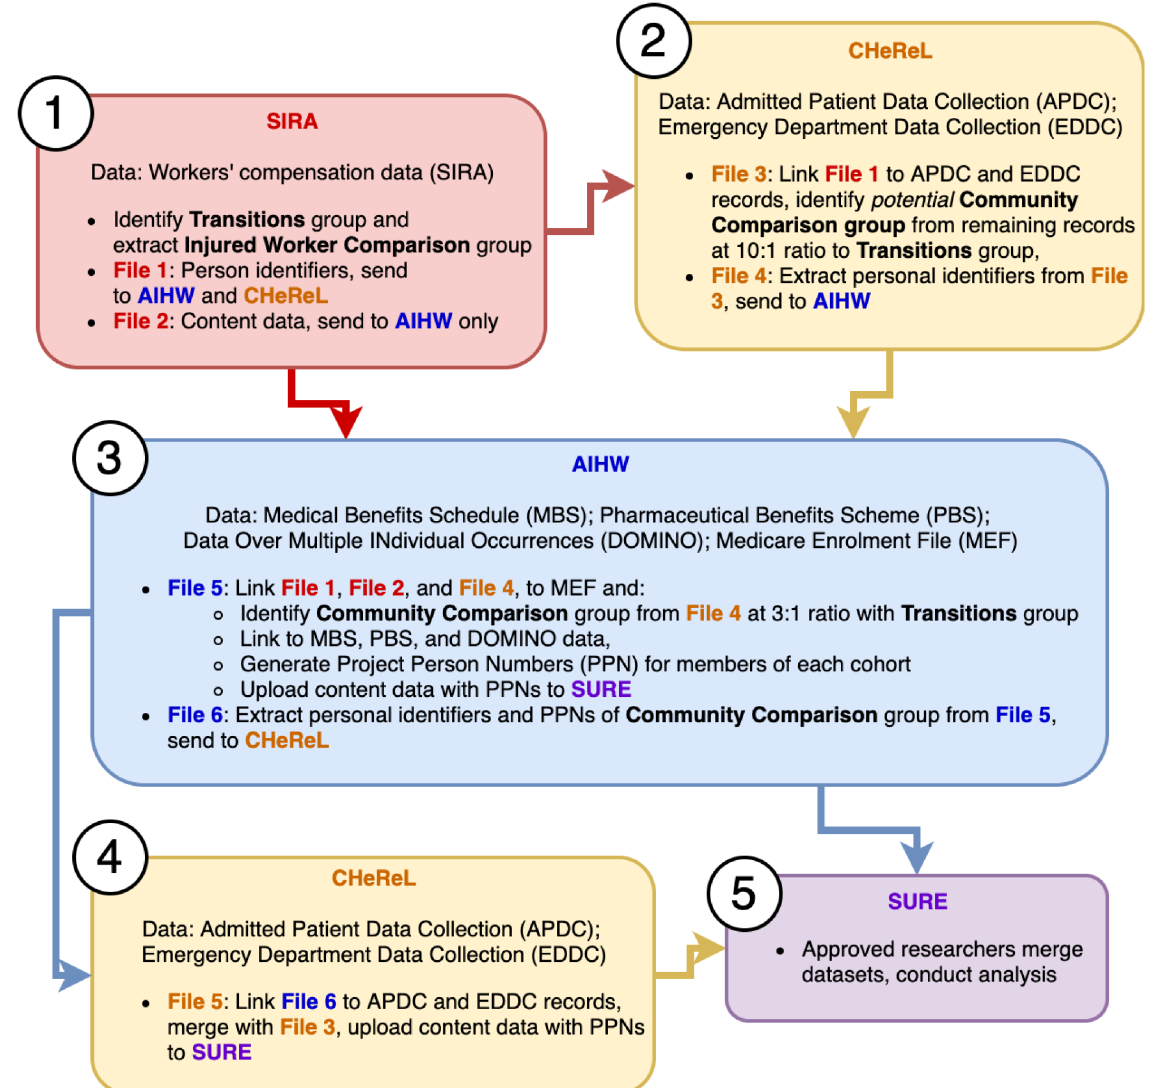
Figure 2: Data linkage flowchart between the State Insurance Regulatory Authority (SIRA), Centre for Health Record Linkage (CHeReL), Australian Institute of Health and Welfare (AIHW), and the Sax Institute’s Secure Unified Research Environment